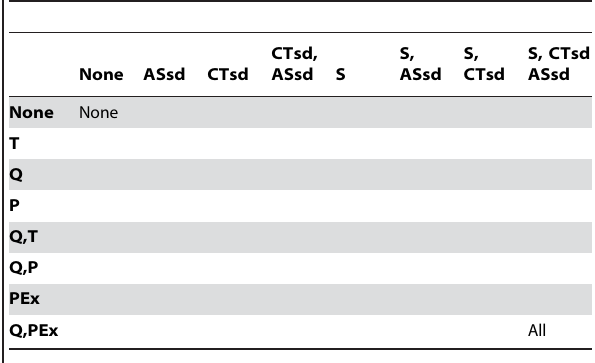
Table 2. Combinatory strategy matrix: Case-based as rows, network-based as